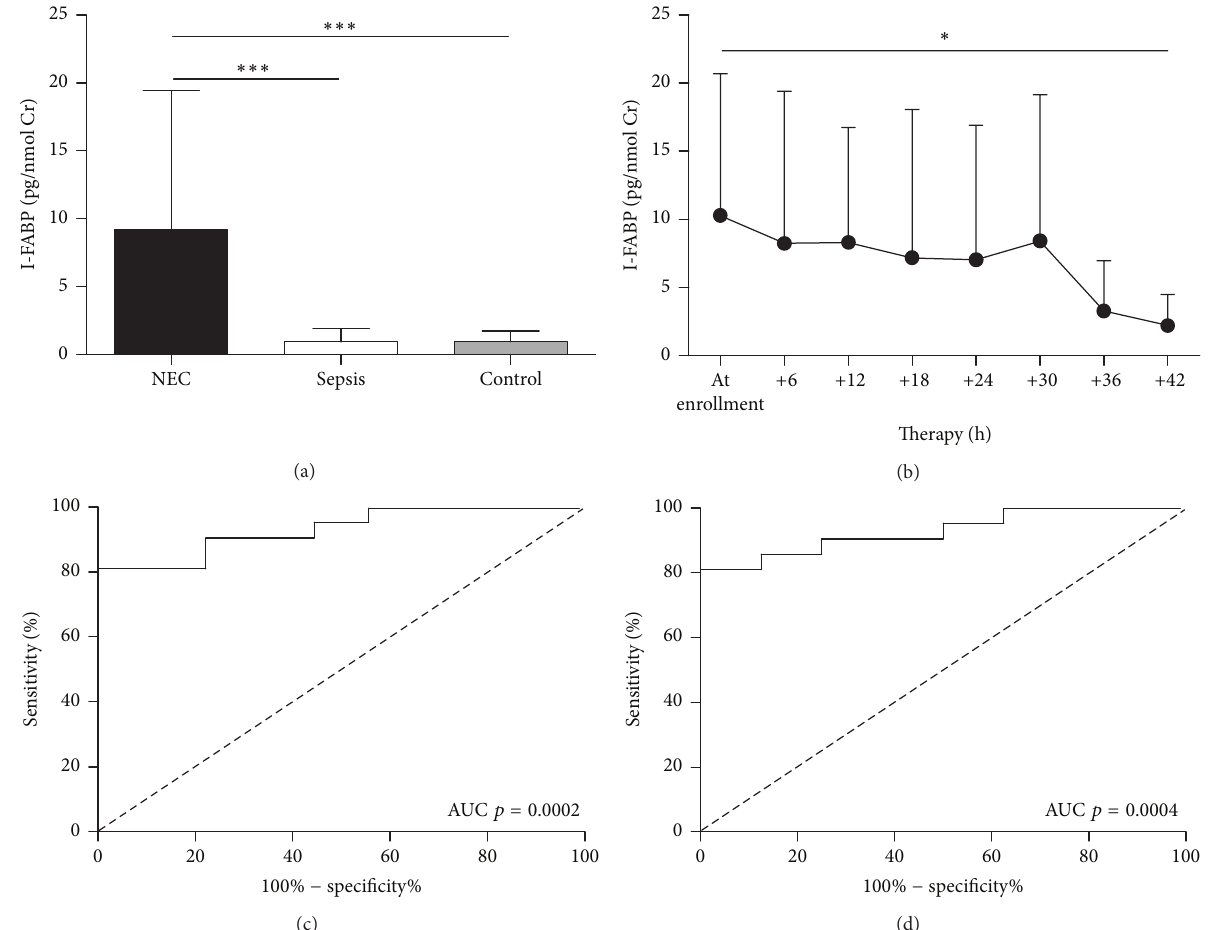
Figure 3: The analysis of I-FABP levels in urine. (a) The I-FABP levels in first twelve hours from the time of enrollment ( ∗∗∗ 𝑝 < 0.001 , Mann-Whitney test) and (b) the dynamics of I-FABP in urine in NEC patients ( ∗ 𝑝 < 0.05 , paired Student’s 𝑡 -test). The ROC curve analysis using I-FABP levels in (c) NEC and sepsis or (d) NEC and controls.